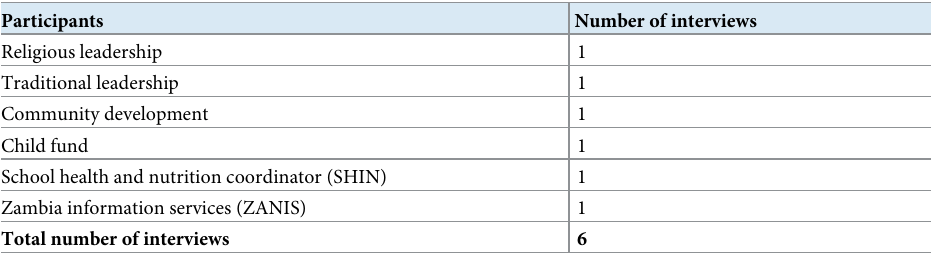
Table 1. In-depth